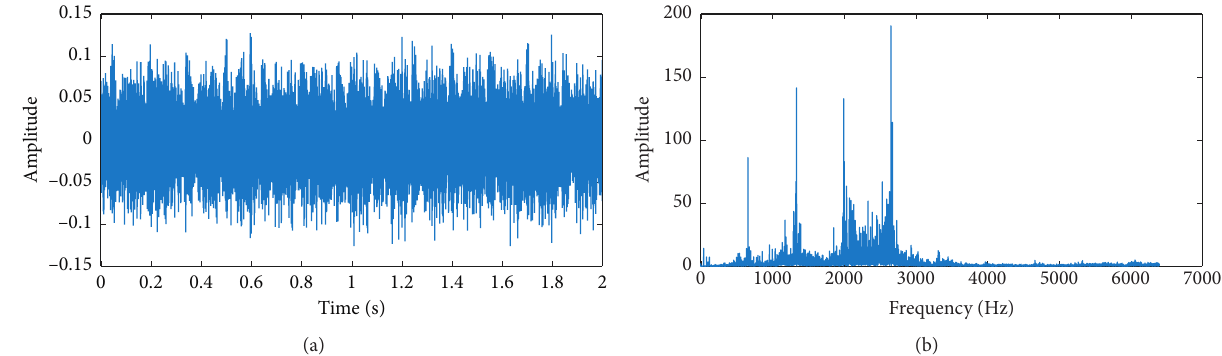
Figure 3: Time domain waveform and spectral diagram of vibration signal of planetary gearbox in healthy state. (a) Time domain waveform. (b) Spectral diagram.